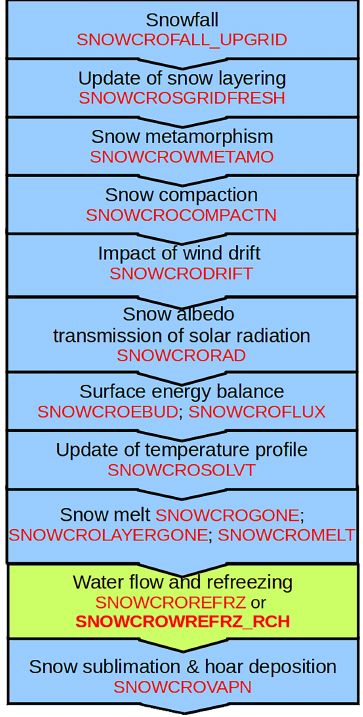
Figure 1. Routines in the Crocus snowpack model with the water percolation routines highlighted in